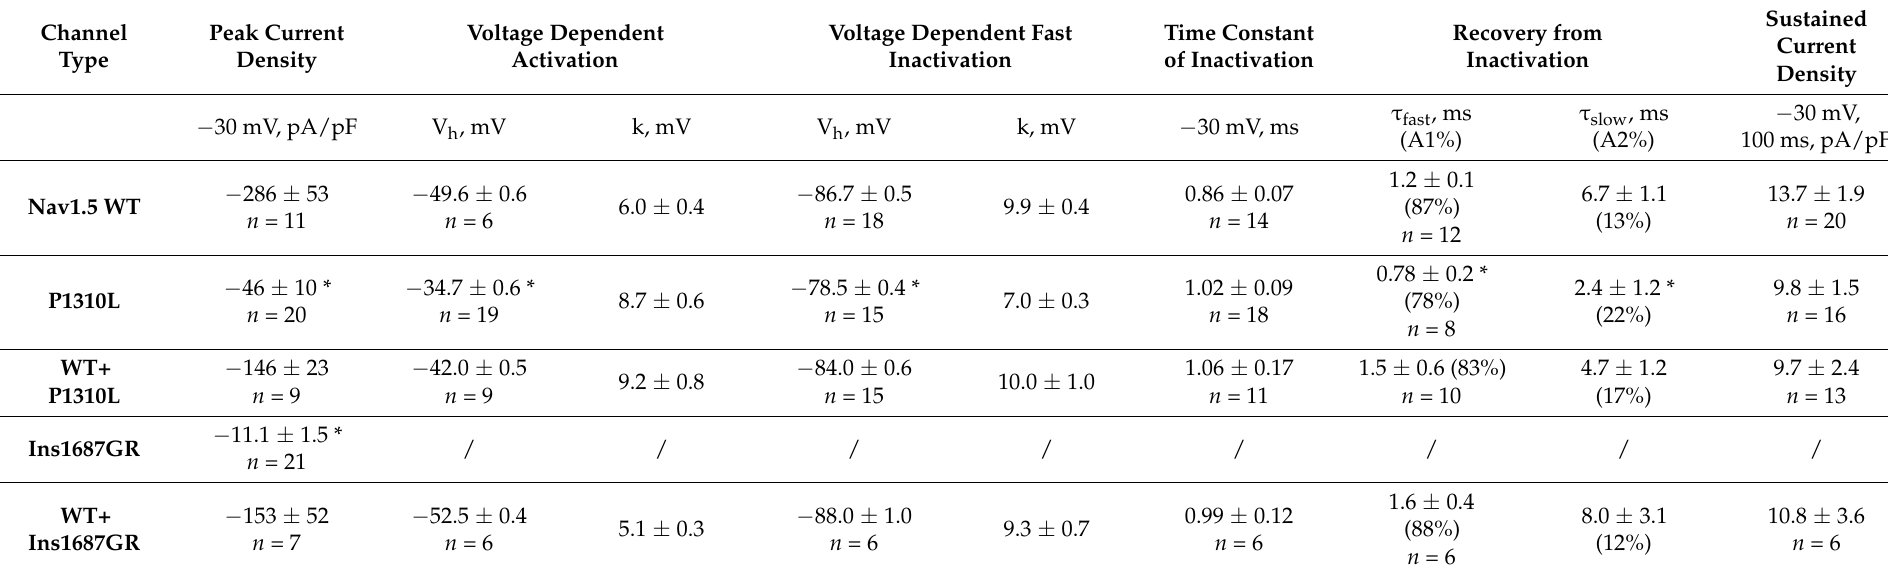
Table 1. Current density and biophysical parameters of Nav1.5 WT and BrS mutant P1310L and Ins1687GR